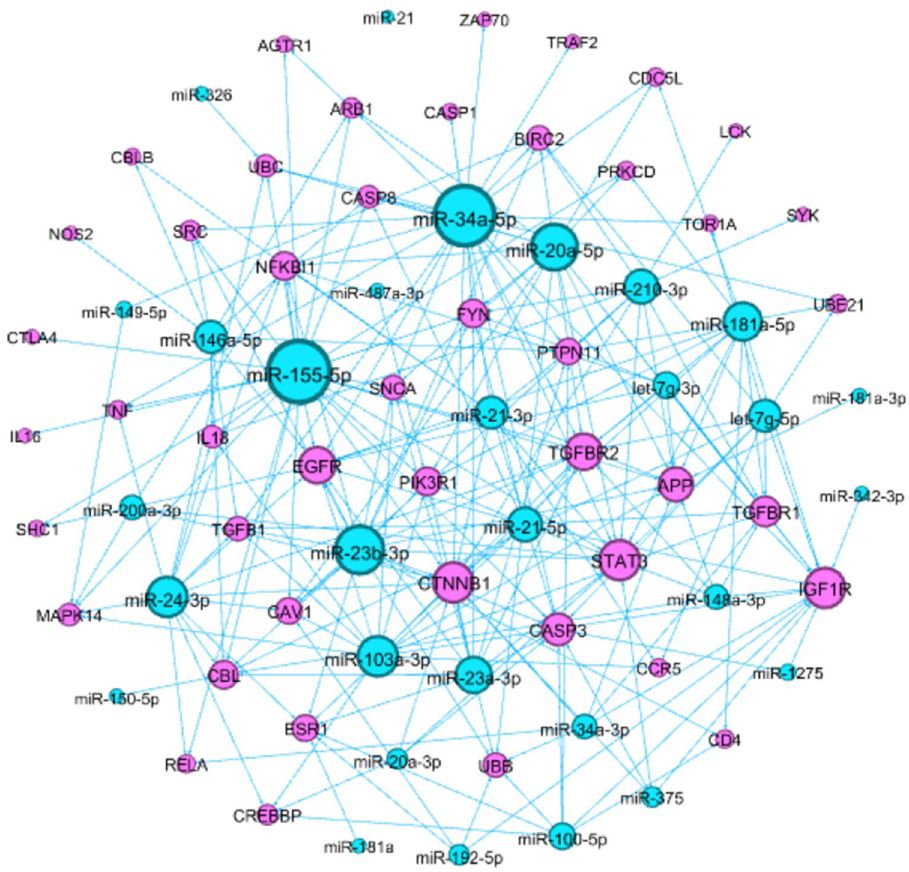
Figure 3. The interaction network between T1D-related miRNAs (blue) and backbone-proteins (red). The interaction network was generated using Gephi v0.9.2 29 (https:// gephi.